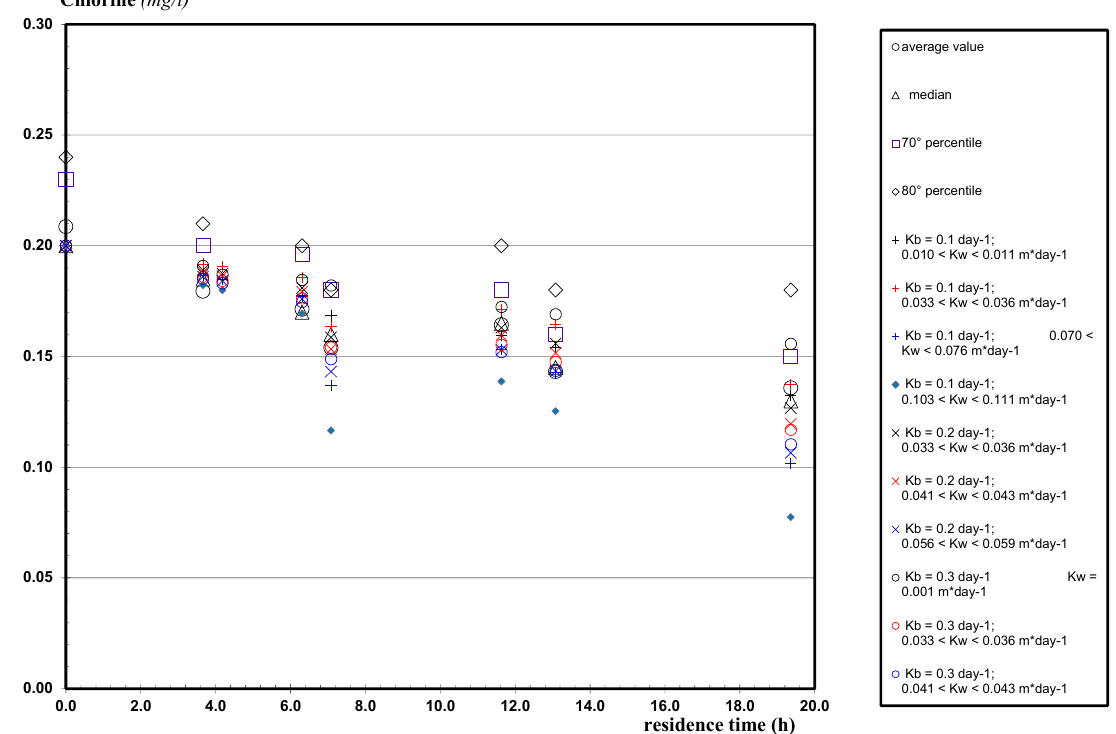
Figure 6. Comparison between calculated values and statistical parameters of the observed data.